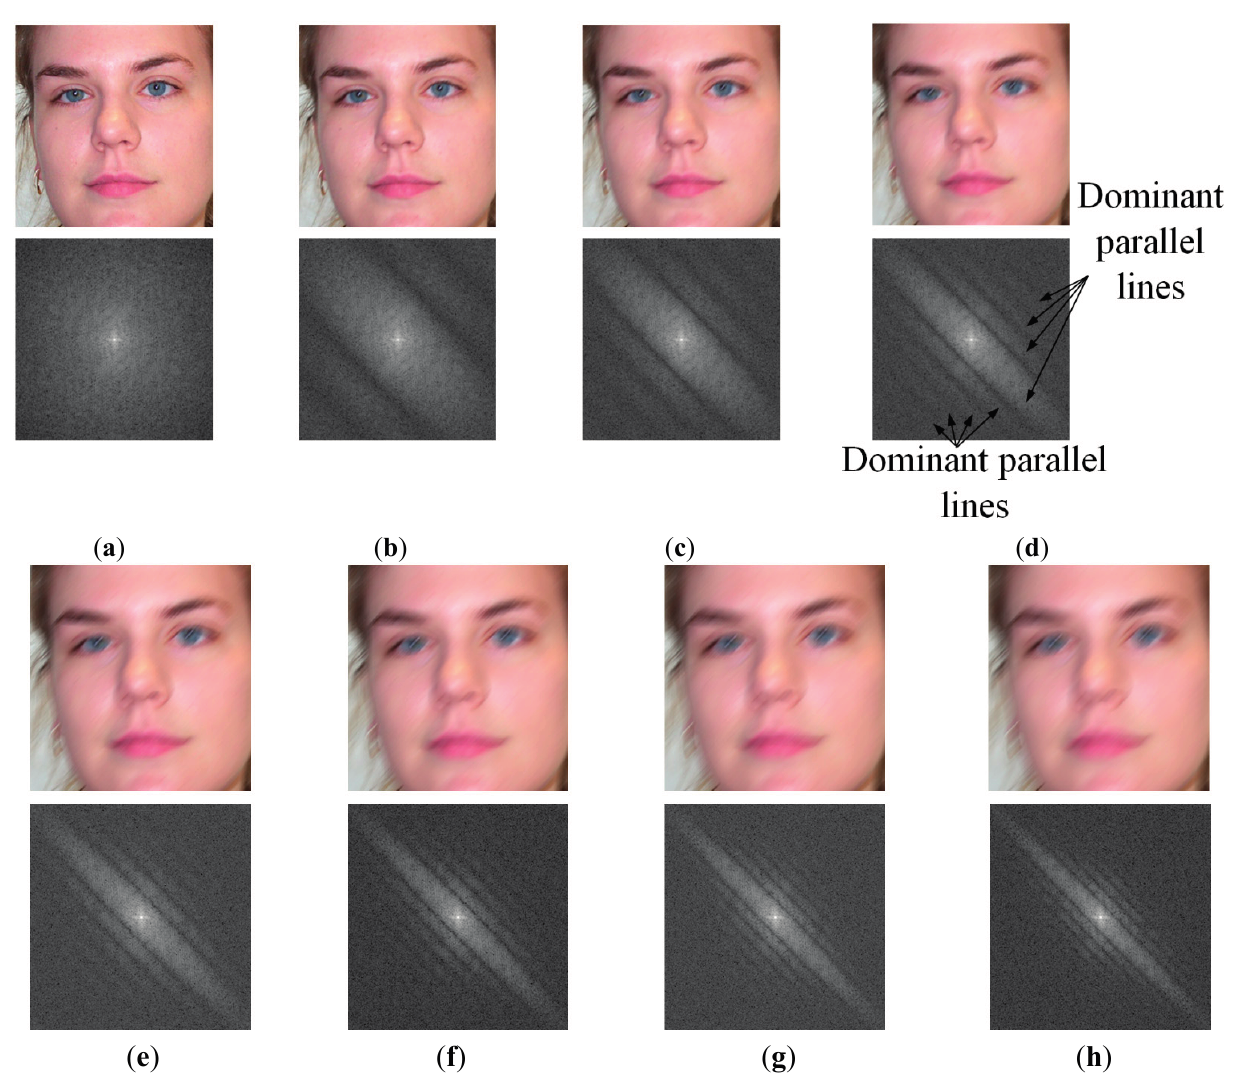
Figure 5. Examples of motion-blurred images (upper Figures of a – h ) and corresponding power spectrum (lower Figures of a – h ) with various amounts of motion blur and motion directions: ( a ) case without motion blurring; ( b – h ) cases of motion blurring with motion length from 3 to 15 with step of 2, respectively, and motion direction of